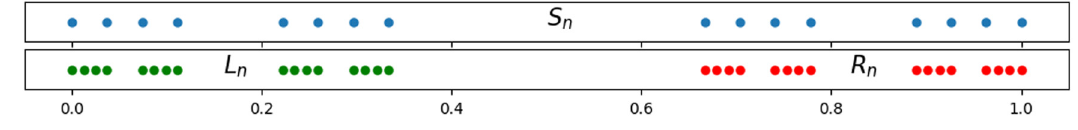
Figure 1: S n divided into the components L n and R n for = n 3